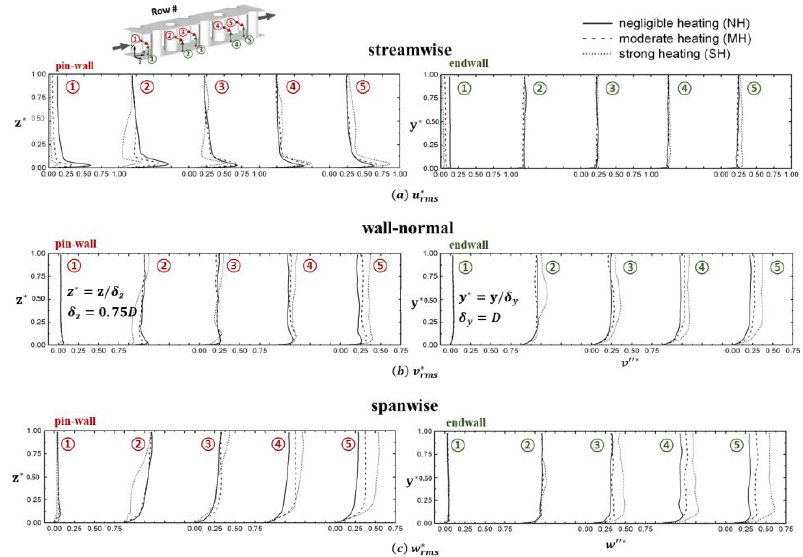
Figure 14. Root-mean square (rms) of the ( a ) streamwise, ( b ) wall normal, and ( c ) spanwise fluctuating velocities as a function of heating load.